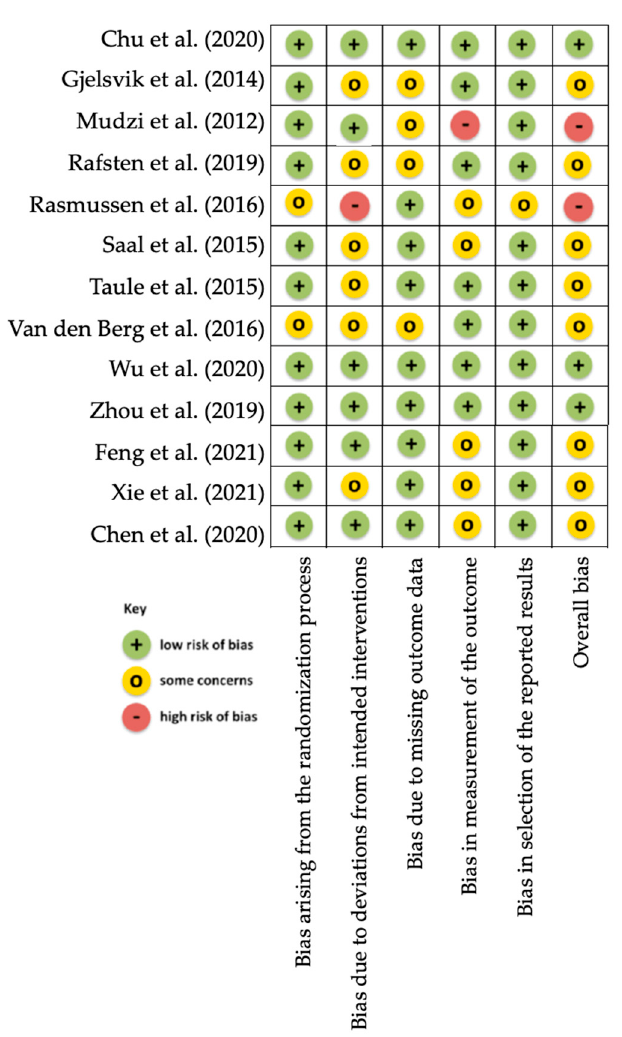
Figure 1. Risk of bias assessment according to the Cochrane Collaboration’s tool (RoB 2.0) for randomised controlled trials.